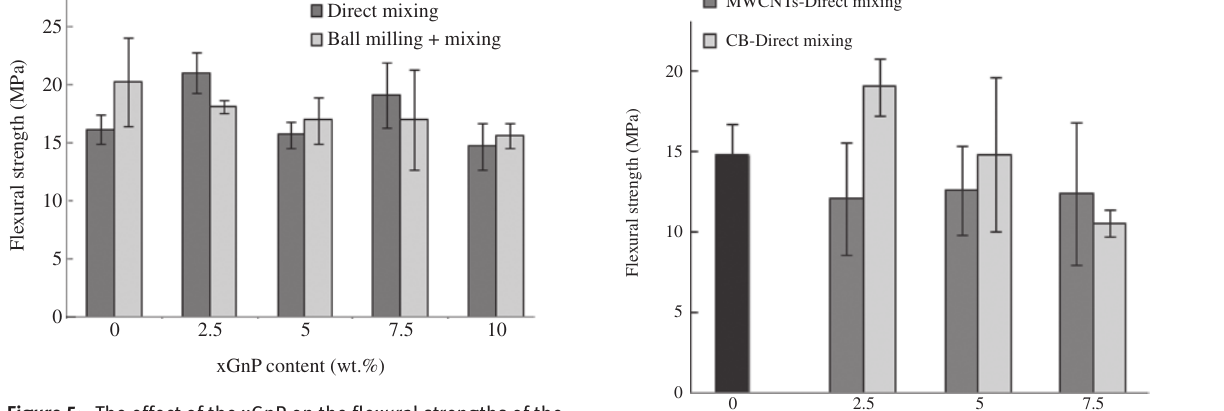
Figure 5: The effect of the xGnP on the flexural strengths of the PP/SG/xGnP composites.